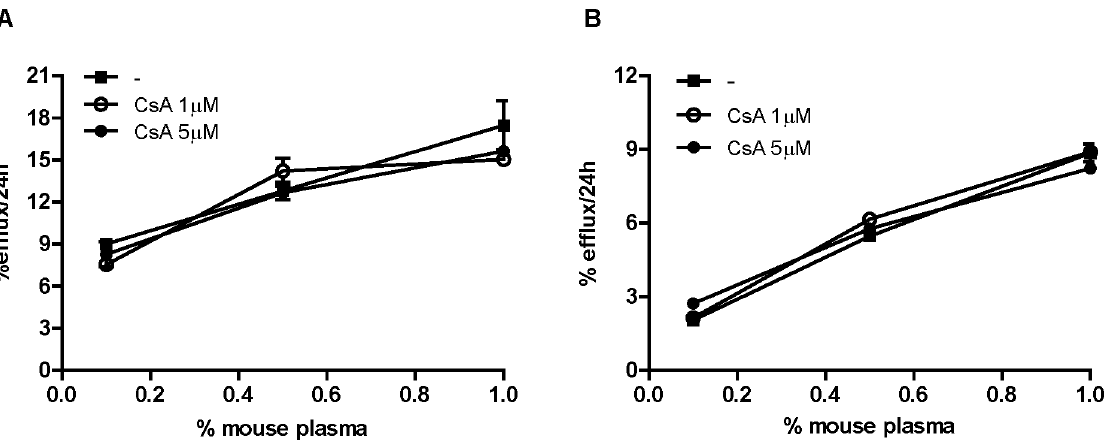
Figure 4. CsA effect on cholesterol efflux from macrophages. A: MPM and B: J774 were cholesterol enriched with AcLDL 25 m g/ml and radiolabeled with [ 3 H]-cholesterol 2 m Ci/ml for 48 hours. After an equilibration period of 6 hours, cells were exposed to increasing concentrations of plasma from wild type mice in presence or absence of CsA 1–5 m M for 24 hours. Efflux is expressed as cpm in medium/cpm time zero x100 (mean of triplicates 6 SD).